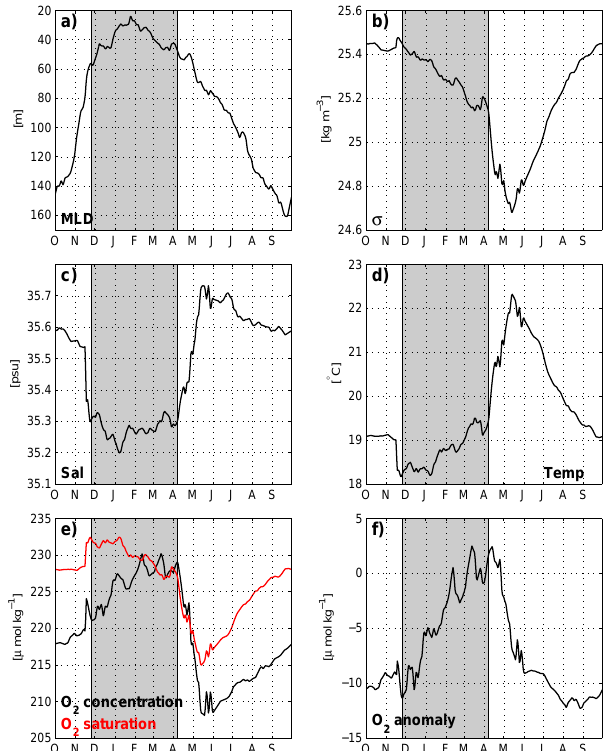
Figure 9. Mean annual cycle for the 5-year period 17 Novem- ber 2008 to 16 November 2013 of float 3900727 in the tropical eastern South Pacific for (a) mixed layer depth (depth where the potential density anomaly is 0.125kgm − 3 larger than at the sur- face), and the distribution at 64m depth for (b) potential density anomaly, (c) salinity, (d) potential temperature, (e) oxygen concen- tration (black curve) and oxygen saturation (red curve), and (f) oxy- gen anomaly (oxygen concentration minus oxygen solubility). An- nual cycle plotted from October to end of September to follow the cycle of the mixed layer depth. The period of oxygen increase be- low the mixed layer between the end of November to early April is highlighted in grey.